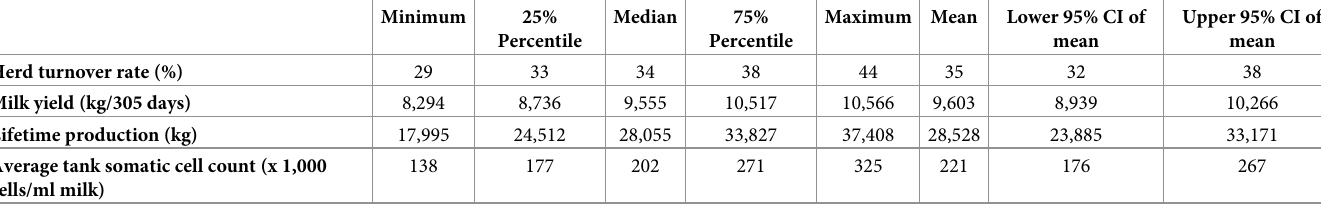
Table 1. Descriptive statistics of the main farm